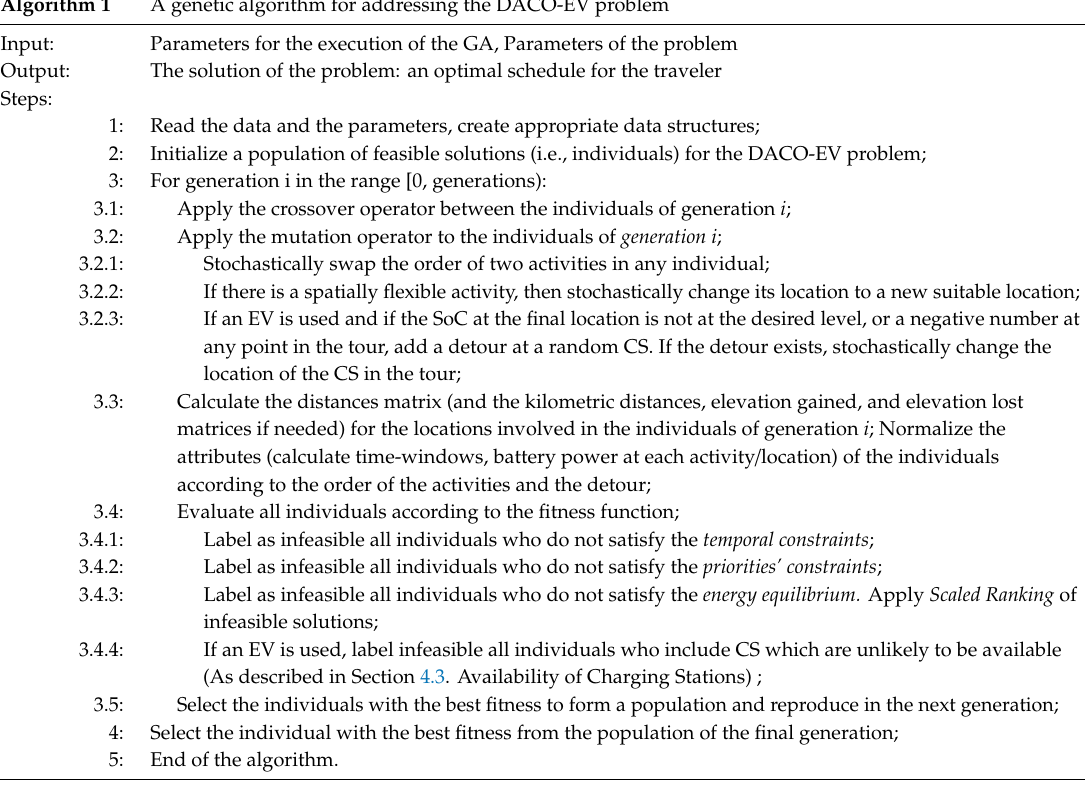
Algorithm 1 A genetic algorithm for addressing the DACO-EV